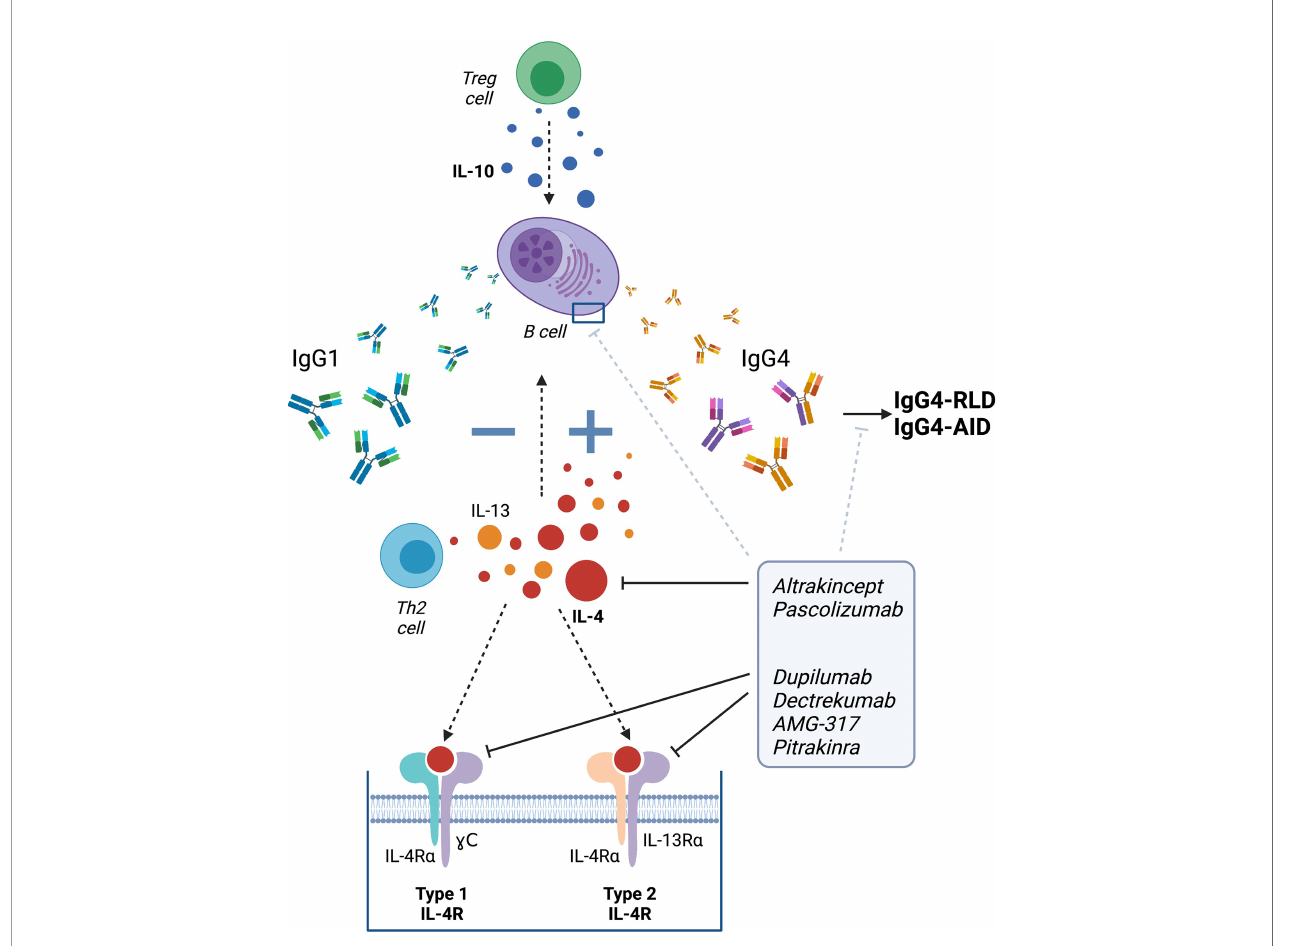
FIGURE 2 | Therapeutic strategies targeting IgG4 class switch via IL-4. Altrakincept, pascolizumab, dupilumab, dectrekumab, AMG-317 and pitrakinra have been developed to prevent the binding of IL-4 to its receptor by blocking the soluble IL-4 or targeting its receptor itself. Targeting IL-4 may help to avert IgG4 class switch and therefore, the development of IgG4-RLD and IgG4-AID. Figure created using